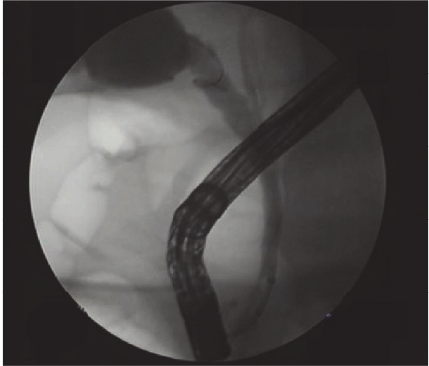
Figure 6: Occlusion cholangiogram after cystic duct stone removal.